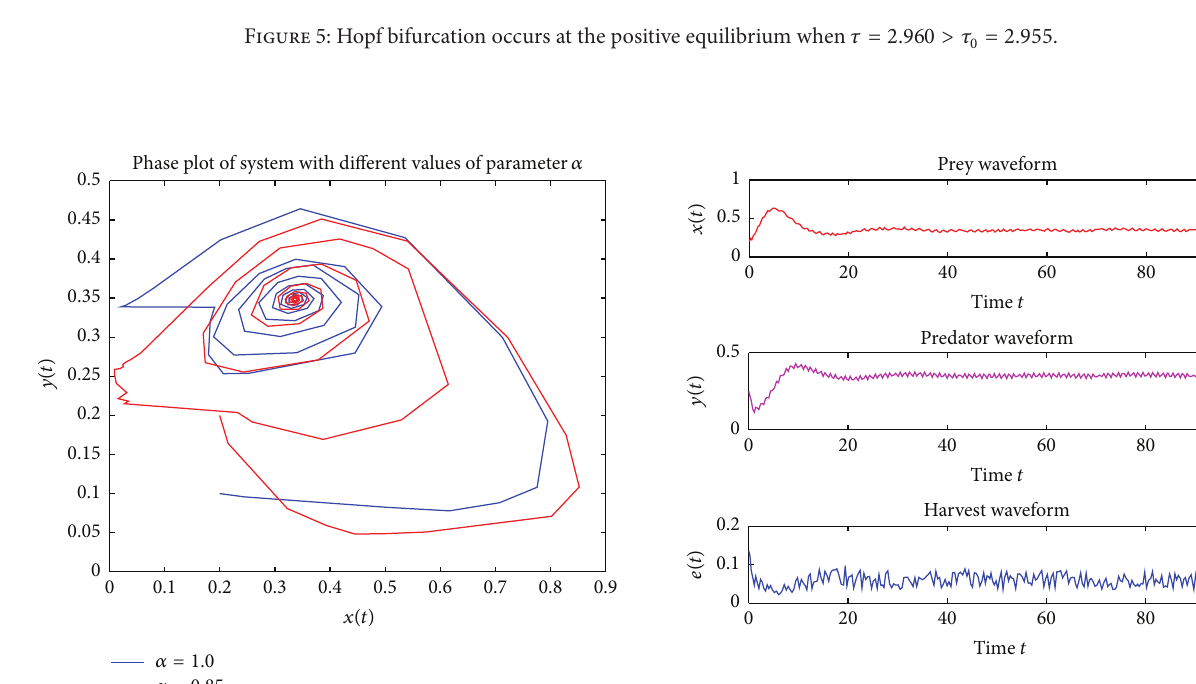
Figure 7: Oscillation solutions of stochastic system (9) in the case of 𝜏 = 1.5